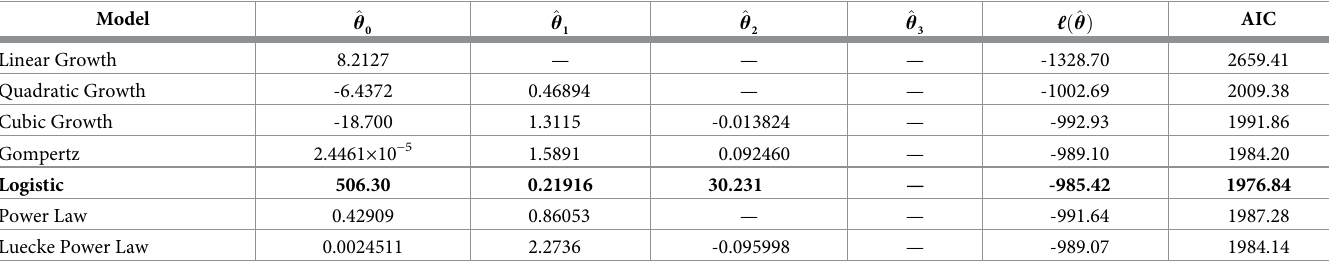
Table 25. Fetal left ventricle blood flow models (mL/min vs. fetal mass in g for power law models, mL/min vs. gestational age in weeks for all other models).